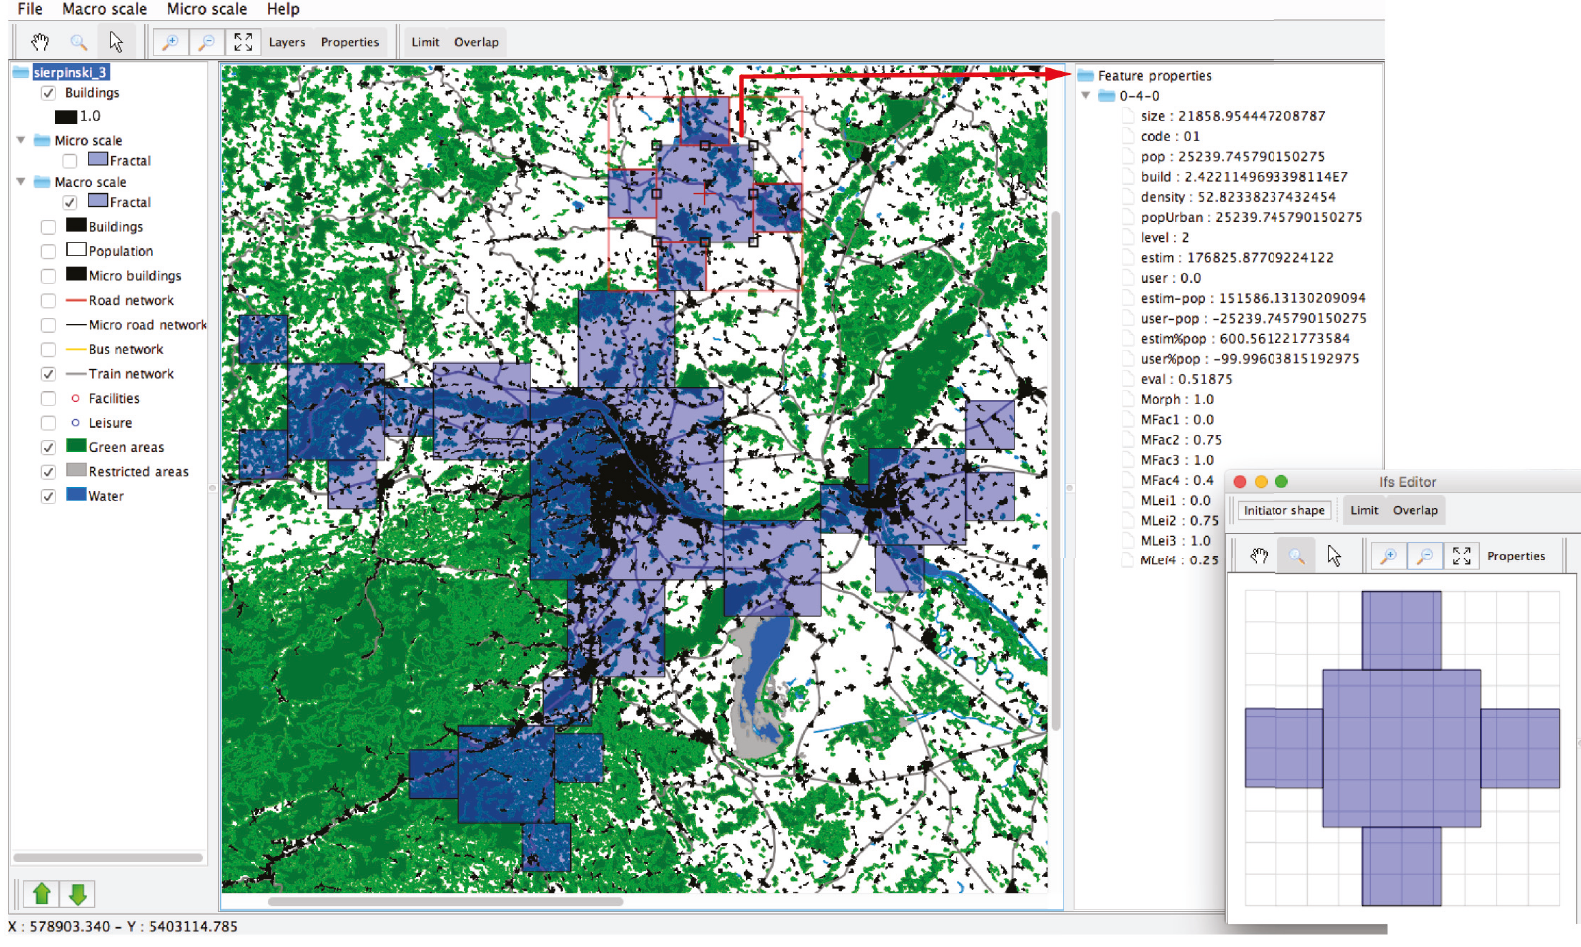
Figure 3. Screenshot of Fractalopolis software.